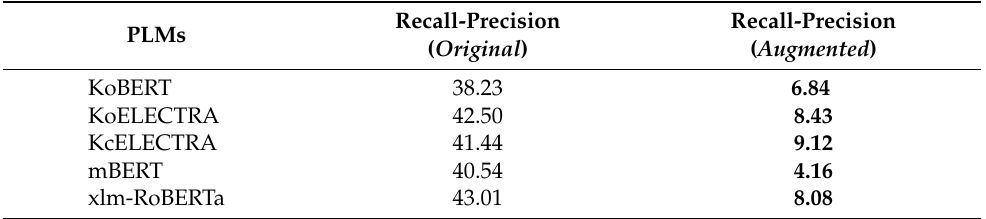
Table 6. Differences between recall and precision, the gaps in our data augmented representations are relatively insignificant. PLMs